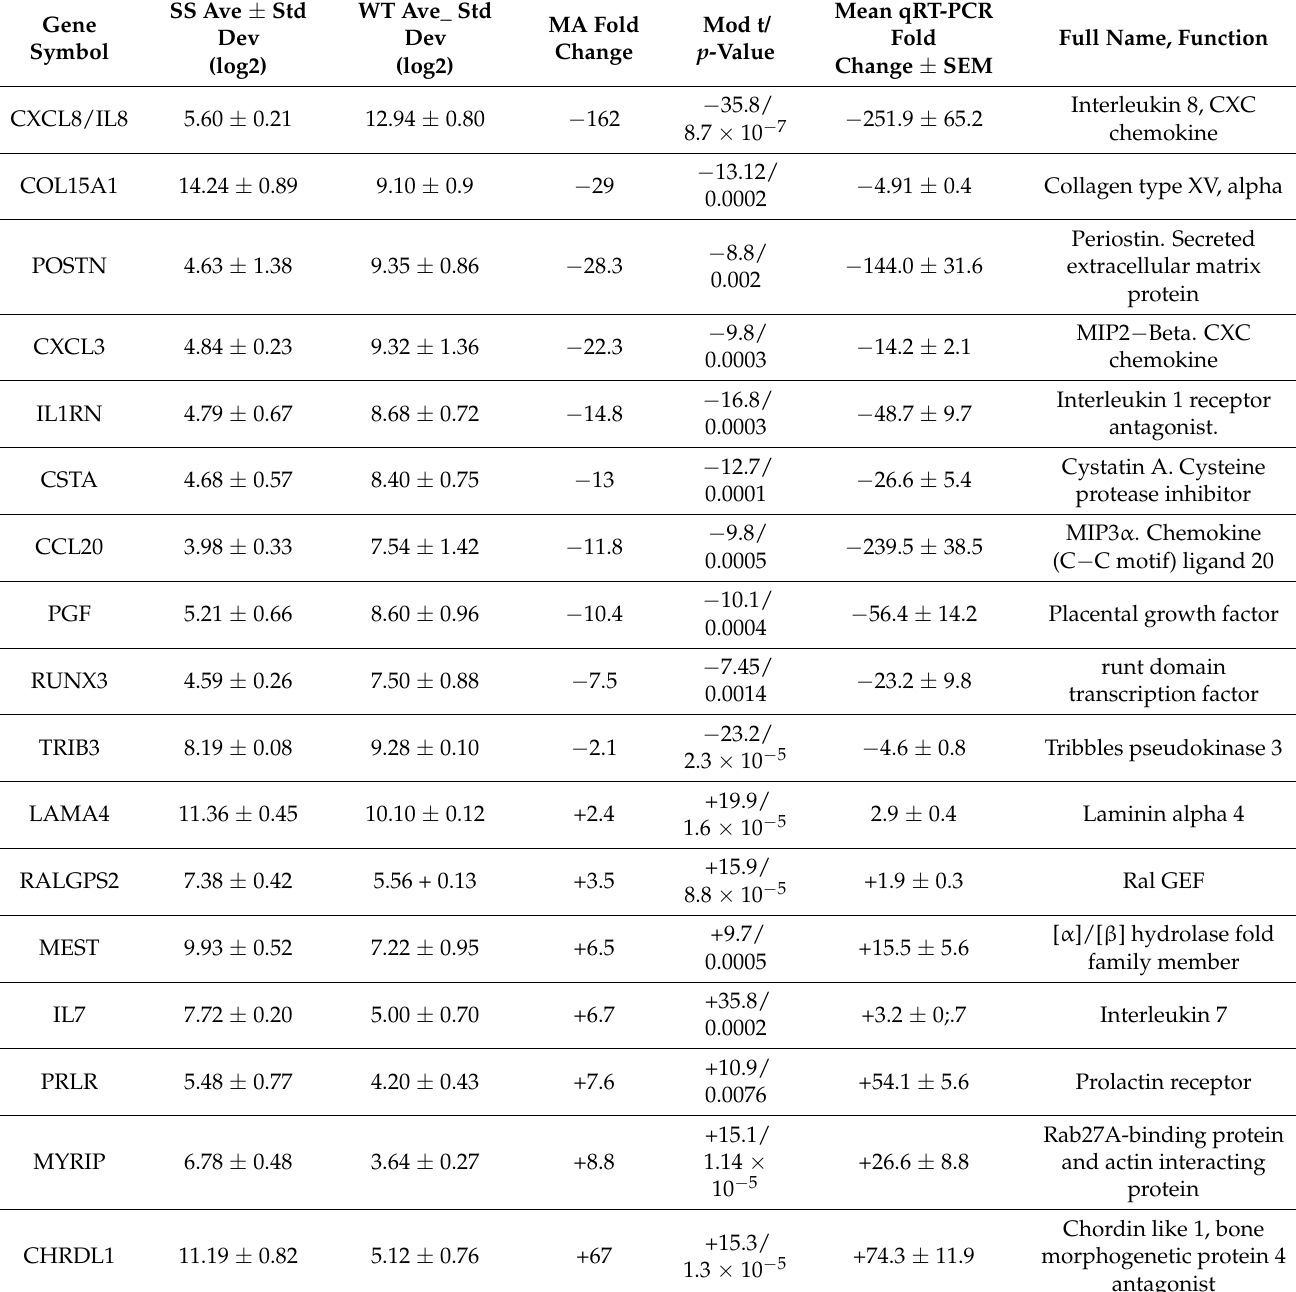
Table 1. Selected genes showing differential hybridization results in Setleis versus control human skin fibroblasts.